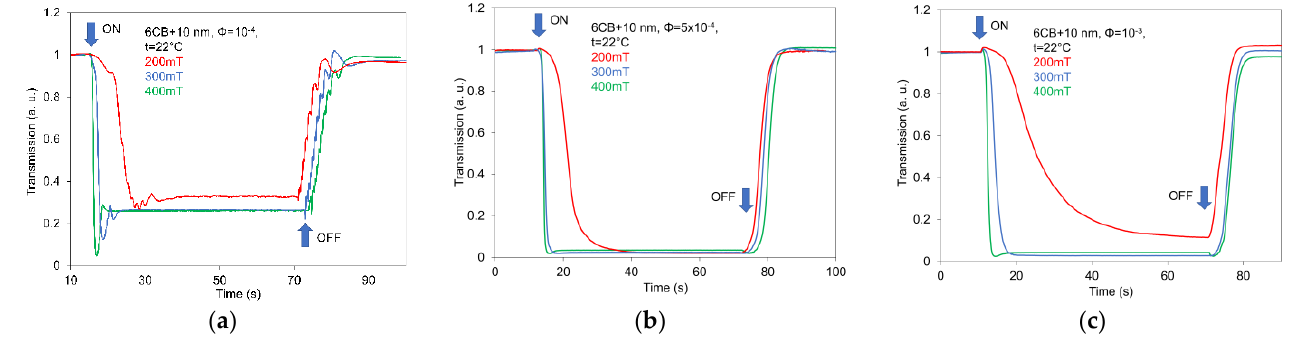
Figure 6. Light transmission time responses registered on 6CB liquid crystal doped with spherical magnetic nanoparticles of 10 nm size and different concentration 10 − 4 ( a ), 5 × 10 − 4 ( b ), and 10 − 3 ( c ) after jumped magnetic field changes of 200 mT, 300 mT, and 400 mT were applied.